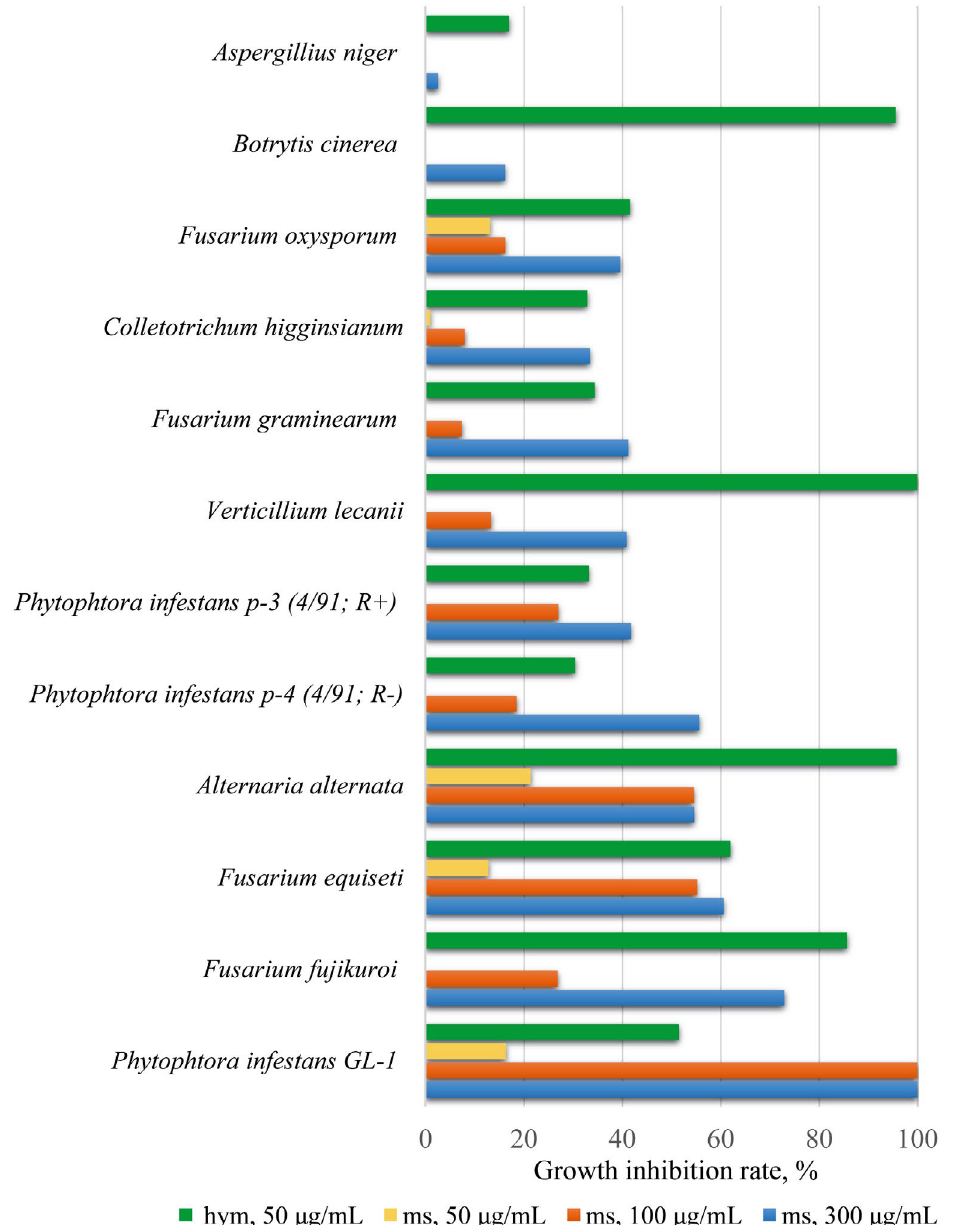
Figure 2. Growth inhibition of studied fungal strains by hymexazol (hym) in 50 μg/mL and monomethyl suberate (ms) in 50, 100 and 300 μg/mL. Mucor indicus and Penicillium digitatum were insensitive in all tests.